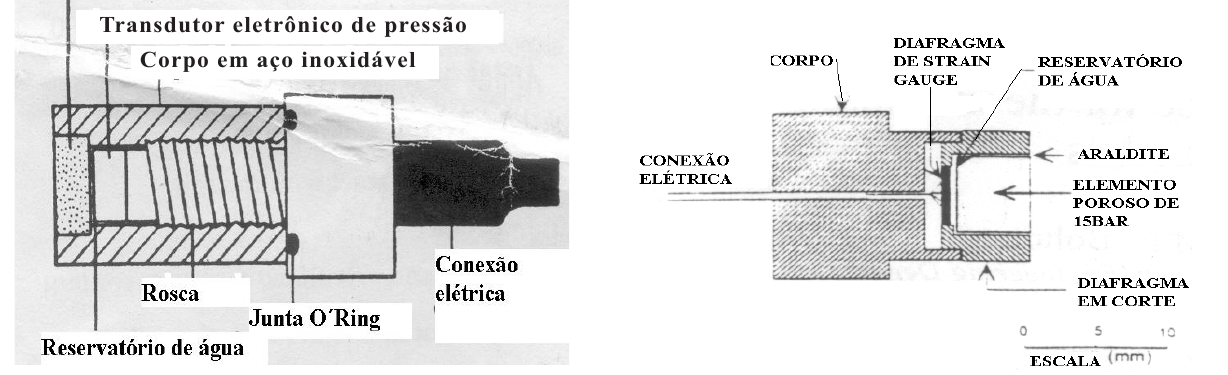
Figura 1. Tensiômetro desenvolvido no Imperial College - Inglaterra. (Ridley & Burland, 1993)